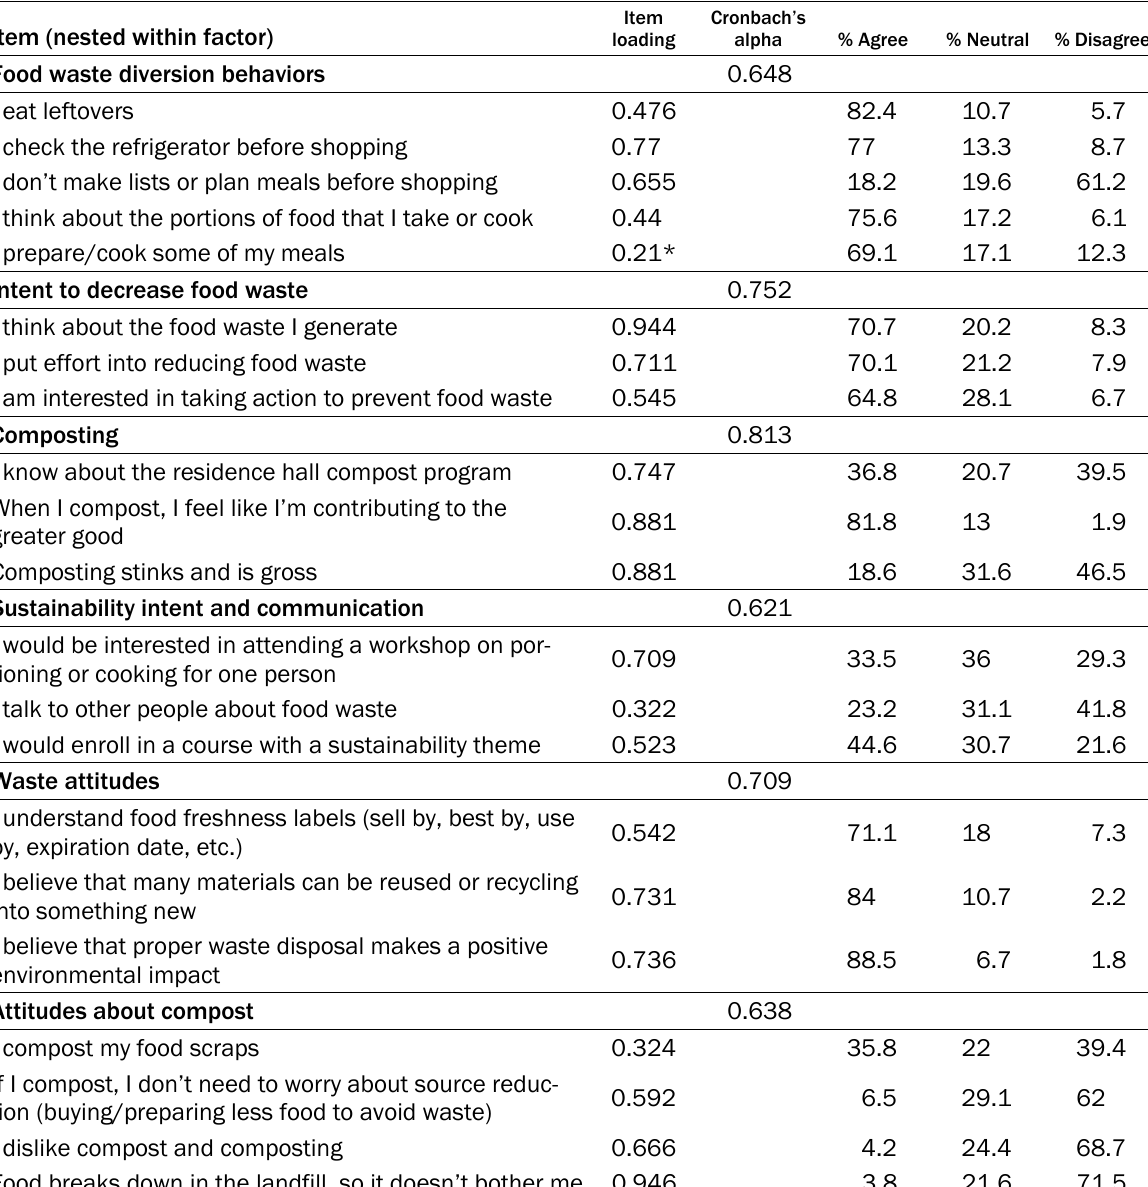
Table 1. Summary of Likert Items and Factor Indexes Item (nested within